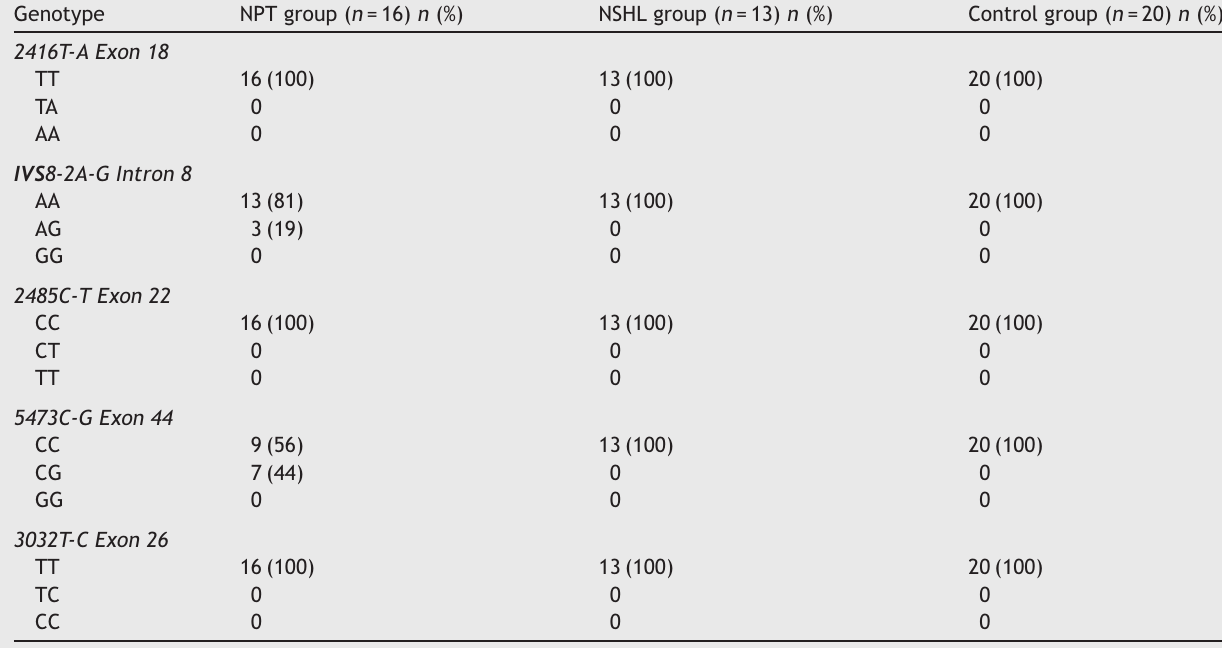
Distribution, in percentages, of the genotypes found in the three groups assessed for the five mutations in the OTOF